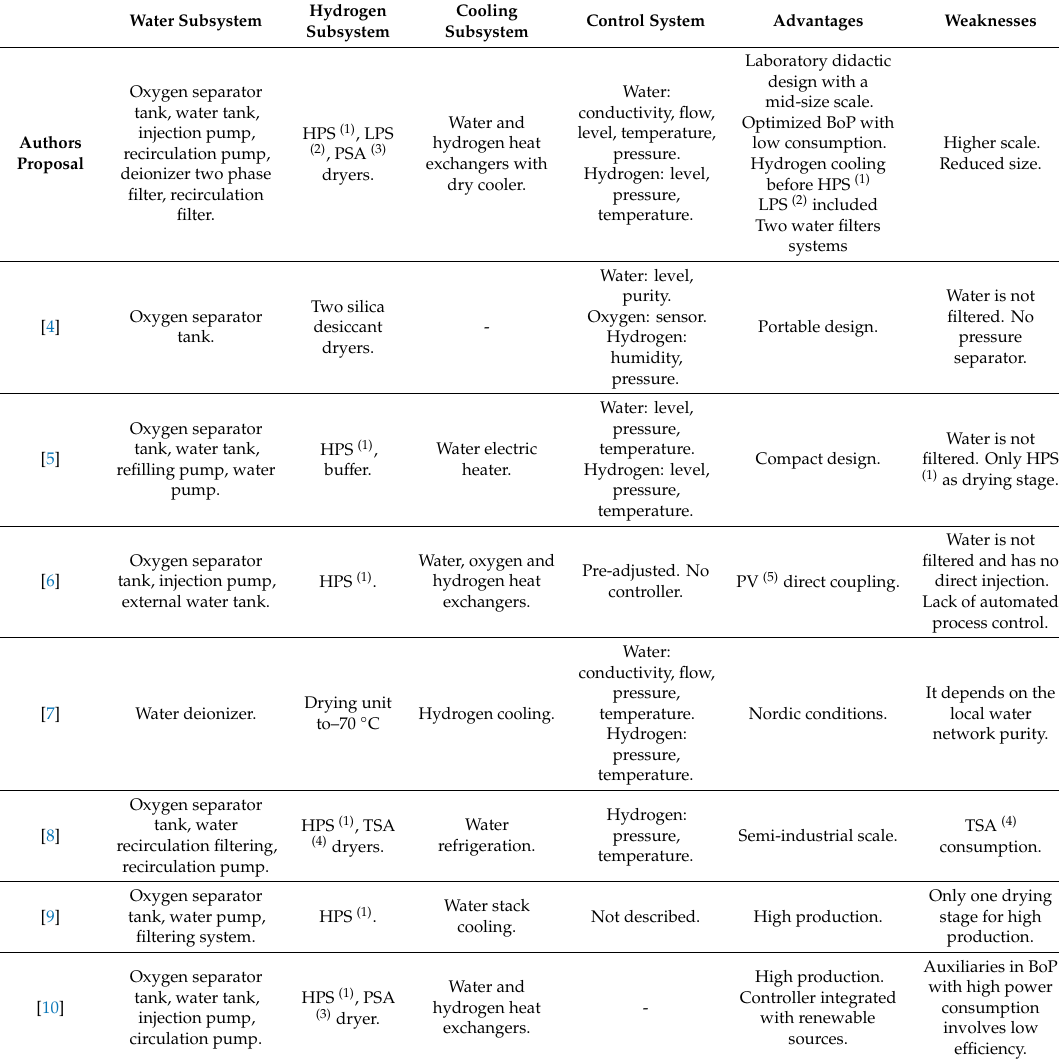
Table 1. Qualitative comparison of proposed polymer electrolyte membrane (PEM) electrolyzer with previous scientific